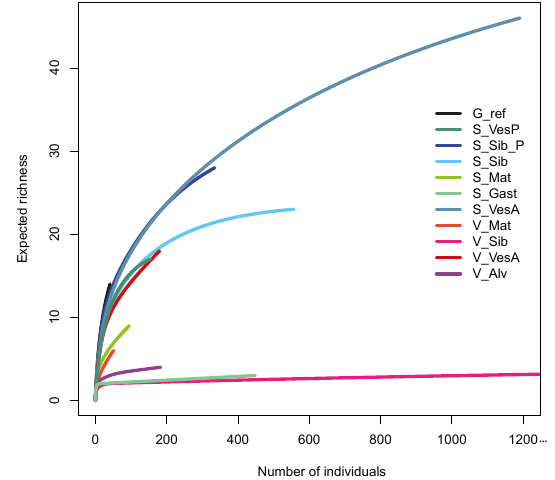
Figure 6. Logarithmic regression between species richness, ES(41), and maximum methane concentration in all macrofaunal assem- blages. Black squares represent observed data points and red squares represent fitted